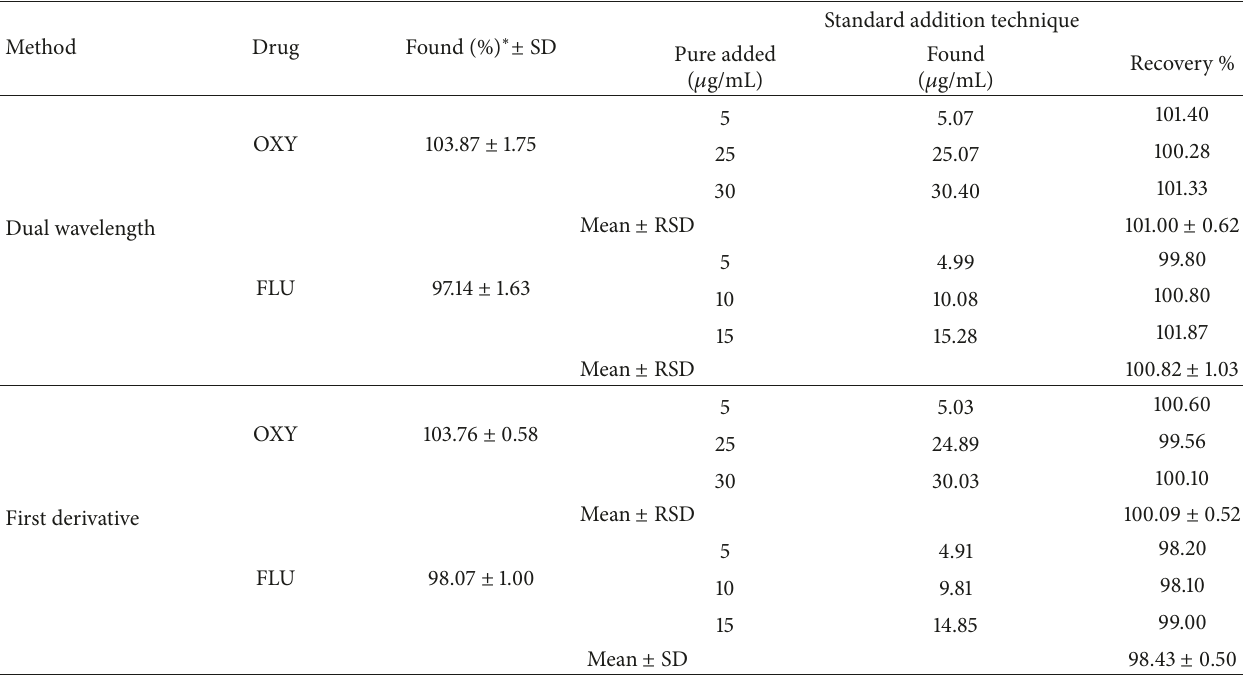
Table 3: Determination of Oxytetracycline HCl and Flunixin Meglumine in FLOXON by the proposed dual wavelength and first-derivative spectrophotometric methods and application of standard addition technique.